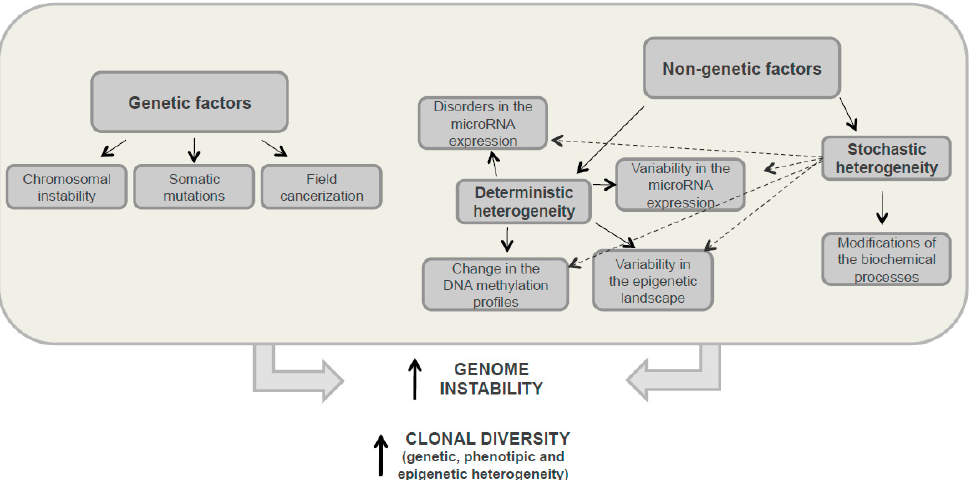
Figure 3. Development factors for tumour heterogeneity. This diagram shows the genetic and non-genetic mechanisms that occur in tumour cells enhancing genome instability and leading to both increased clonal diversity, and the development of genetic, phenotypic and epigenetic heterogeneity. Solid arrows indicate strict regularities and dotted arrows indicate possible relations.